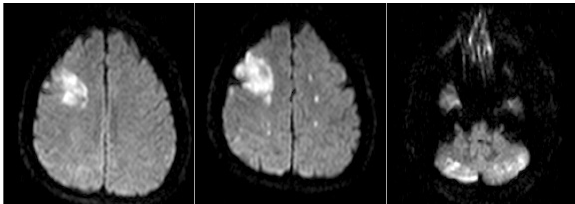
Figure 1. Brain MRI showing brain multiple and cerebellar